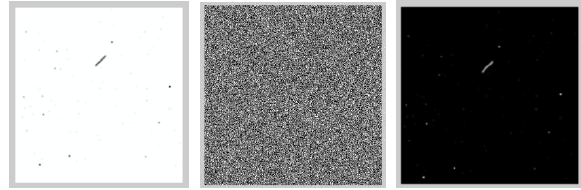
Figure 11. The free-background image (left), the noise (middle), the image without noise and background (right)